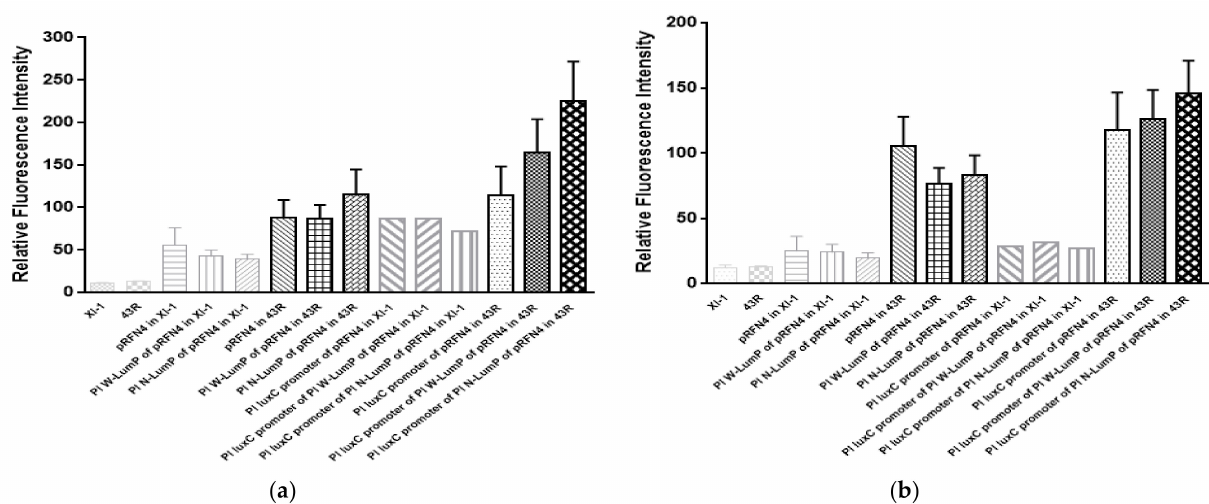
Figure 7. ( a ) Analysis of average fluorescence emission intensity from the different transformants. The x axis of bar graph means relative fluorescence intensity by lumazine in fixation at excitation wavelength of 410 nm from the E. coli transformed with recombinant plasmids from P. leiognathi lux gene. ( b ) Average emission value by riboflavin were obtained in fixation at excitation wavelength of 450 nm. The x axis of bar graph means relative fluorescence intensity from the E. coli transformed with recombinant plasmids from P. leiognathi lux gene.